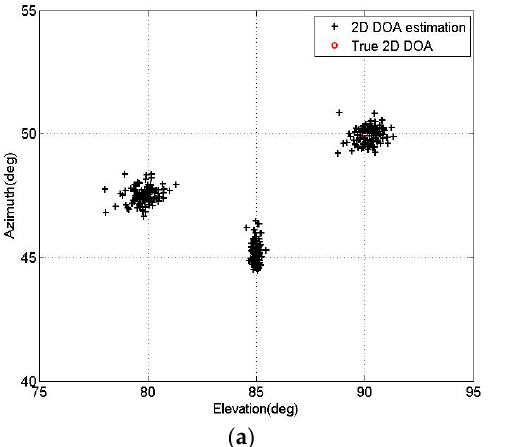
Figure 9. RMSE of four algorithms versus SNR. Figure 10. RMSE of four algorithms versus snapshots.